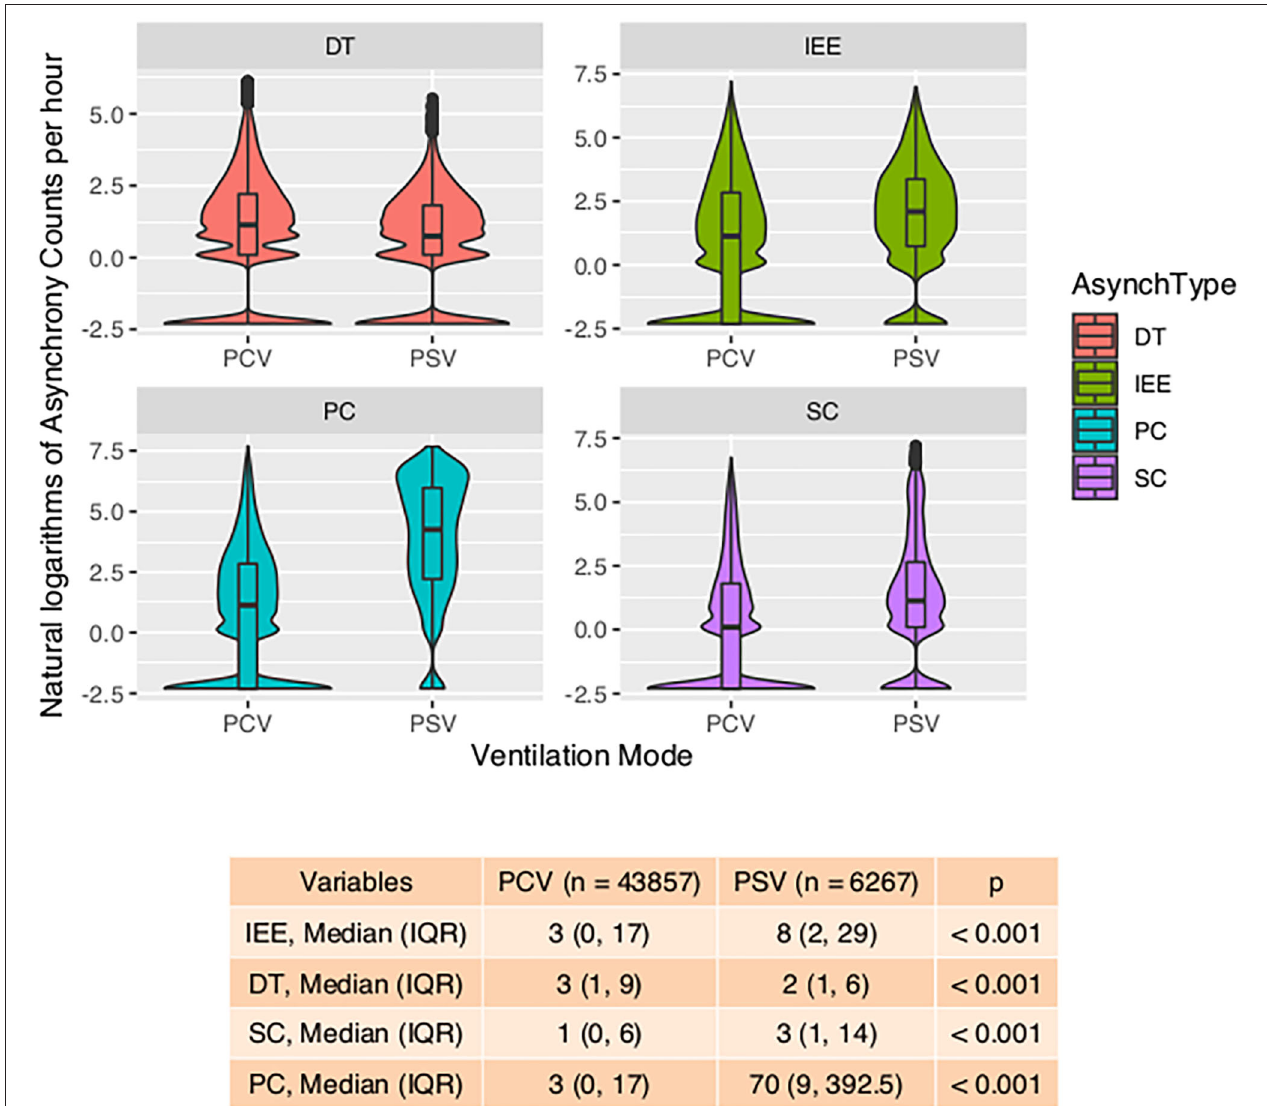
FIGURE 3 | Violin plot showing the impact of ventilation mode on four types of asynchrony. Violin-and-box plots are used to visualize the distribution of the asynchrony counts (transformed by natural logarithms) and their probability density. The table at the bottom shows the number of asynchrony counts per hour. IEE, ineffective effort; DT, double triggering; SC, short cycling; PC, prolonged cycling; PCV, pressure control ventilation; PSV, pressure support ventilation.